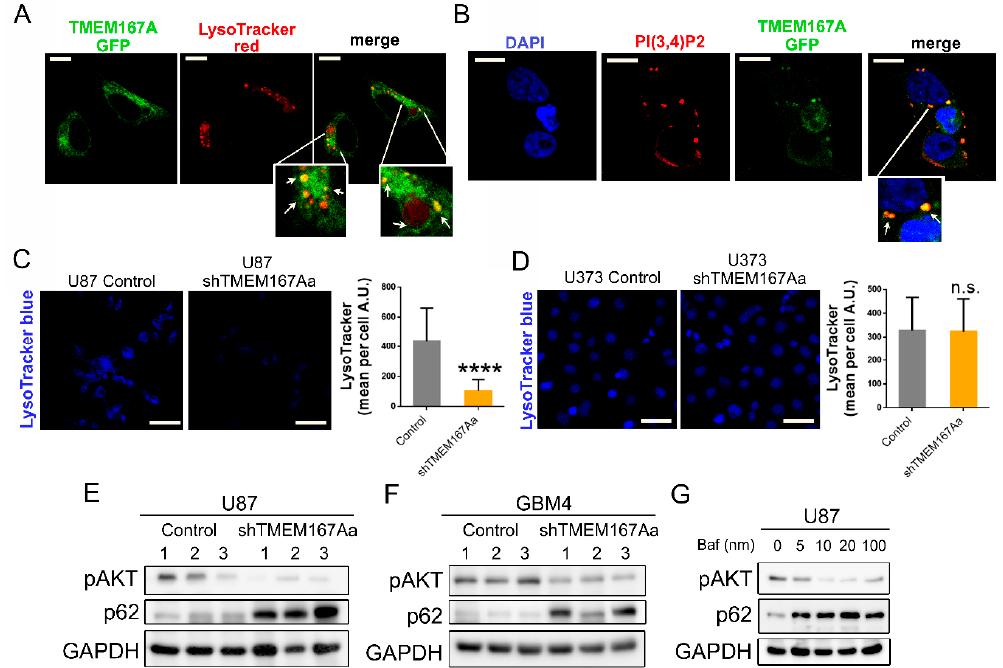
Figure 7. TMEM167A is required for vesicular acidification in wild-type p53 gliomas. ( A ) Representative images of GFP-TMEM167A and LysoTracker co-staining in 293T transfected cells. Arrows point toward colocalizing vesicles. ( B ) Representative images of GFP-TMEM167A and PI (3,4)P2 immunofluorescence (IF) co-staining in 293T transfected cells. Arrows point toward colocalizing vesicles. ( C , D ) Confocal images and quantification of LysoTracker staining in U87 (Control or shTMEM167Aa) cells ( C ) and U373 (Control or shTMEM167Aa) cells ( D ). ( E , F ) WB analysis of pSer473-AKT (pAKT) and p62 in tumors from Figure 3A (E) and 3C (F). GADPH was used as a loading control. ( G ) WB analysis of pAKT and p62 in U87 cells treated with Bafilomycin A1 (Baf) at different concentrations. Scale bar: 10 μ m (A,B), 75 μ m (C,D) **** p < 0.0001, n.s. = nonsignificant.